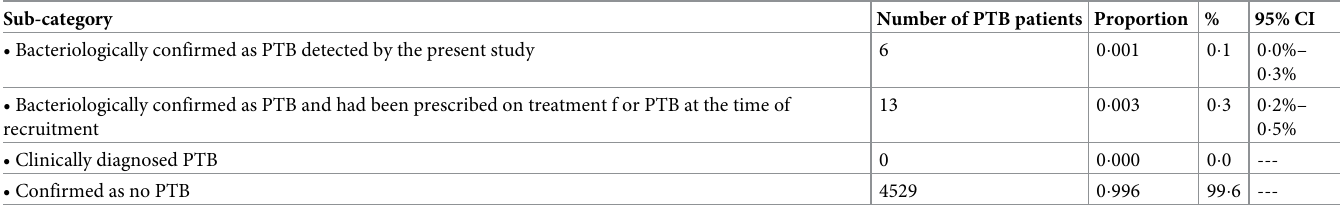
Table 3. Proportions of pulmonary tuberculosis patients detected by the study.